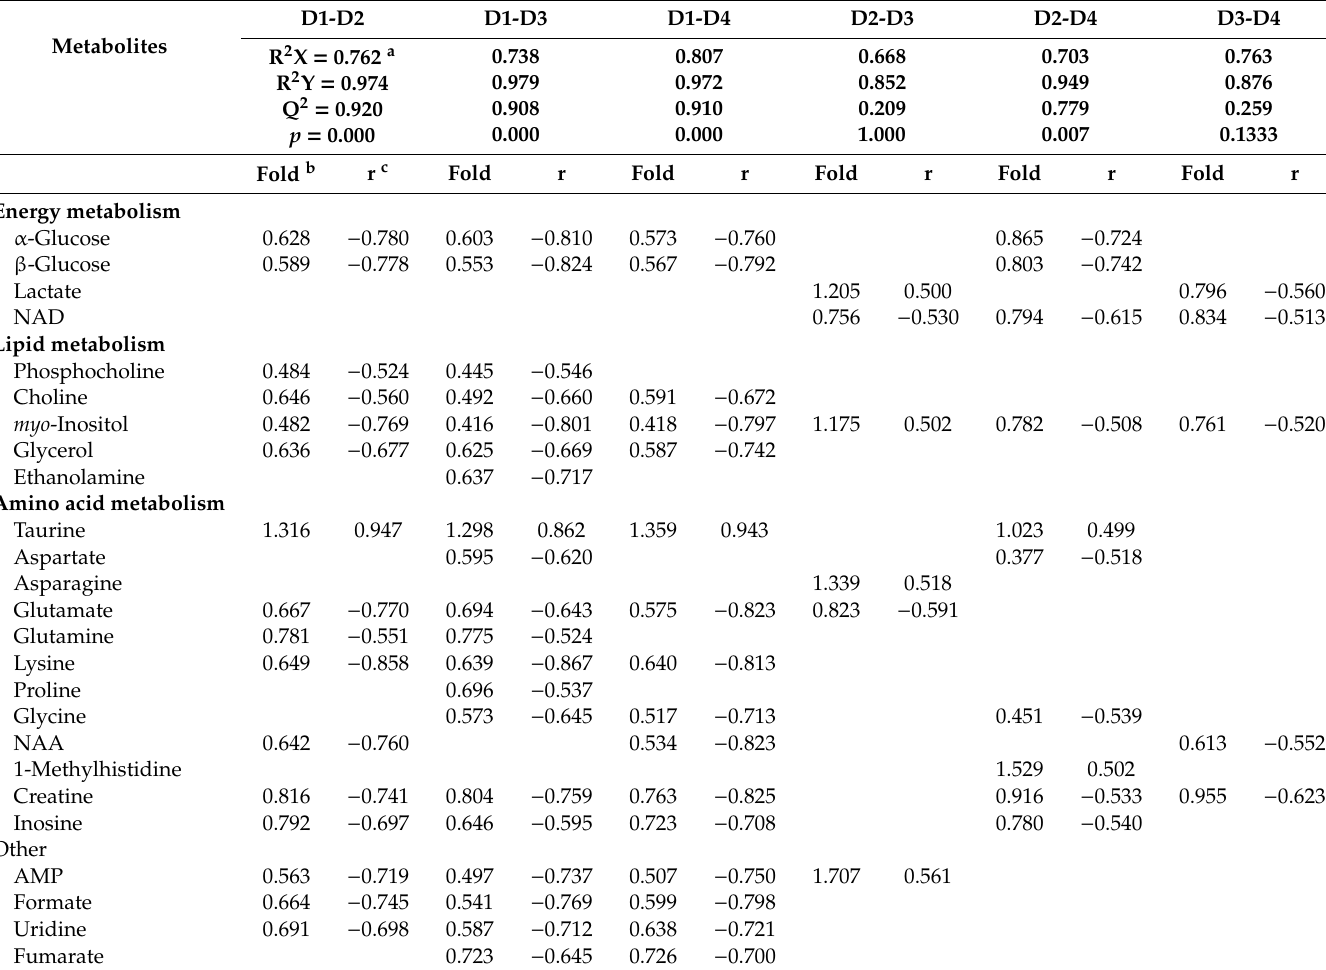
Table 1. OPLS-DA coe ffi cients derived from the NMR data of grouper fed diets with di ff erent taurine levels at